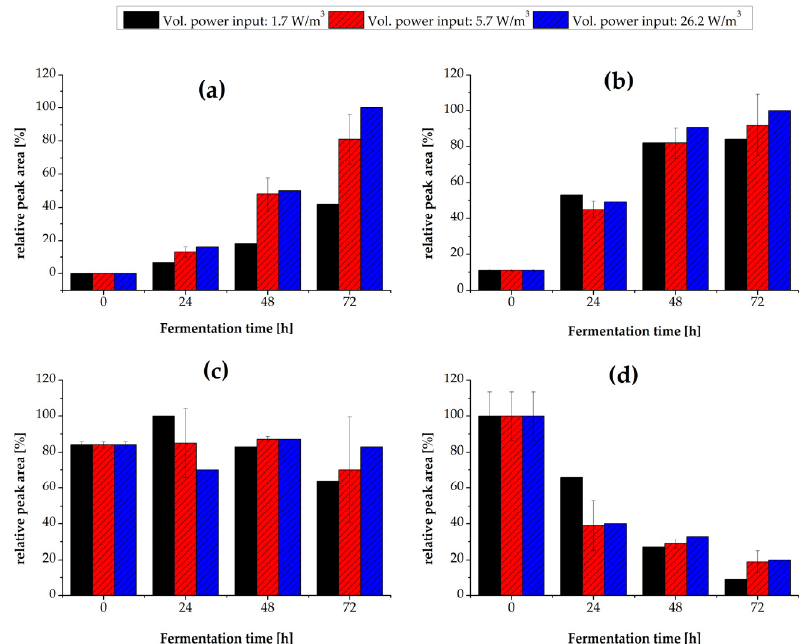
Figure 5. Production of ( a ) methyl-2-methylbutanoate, ( b ) 2-phenylethanol, and degradation of ( c ) β -damascenone, ( d ) methional by shiitake under different volumetric power inputs. Vol.: Volumetric. Error bars are standard errors of the mean for two samples.